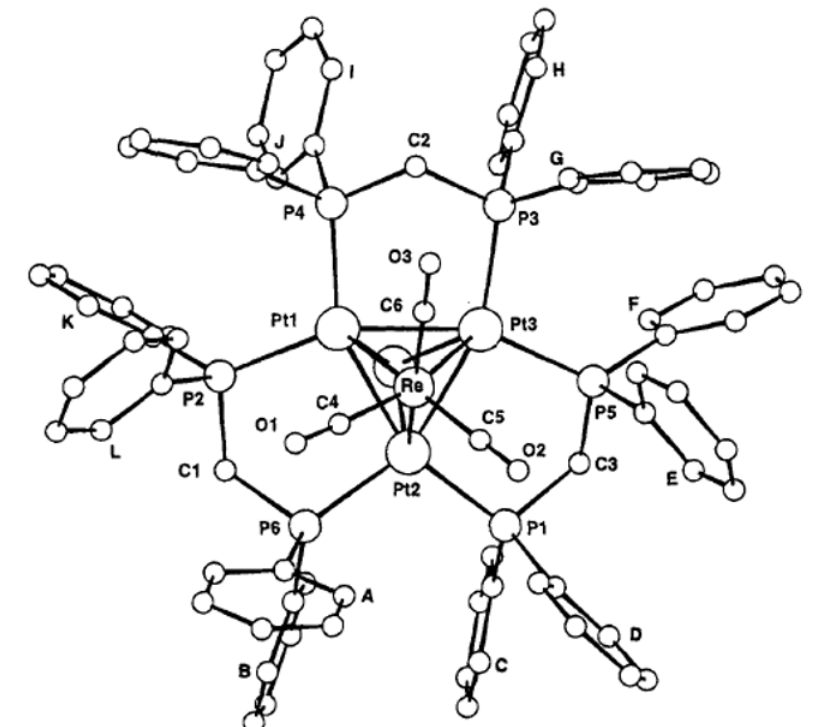
Figure 1. Structure of [(µ- η 2 -dppm)